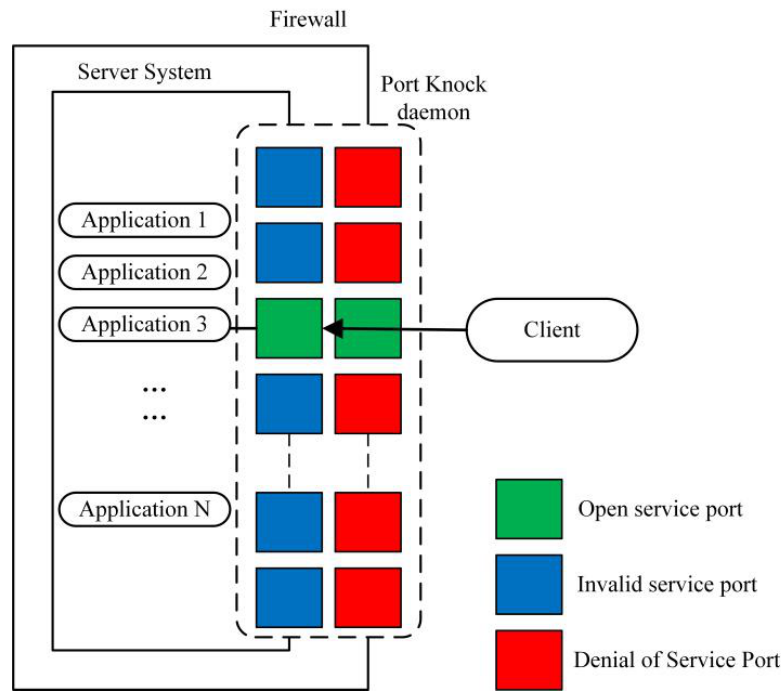
Figure 2. Port Knocking.